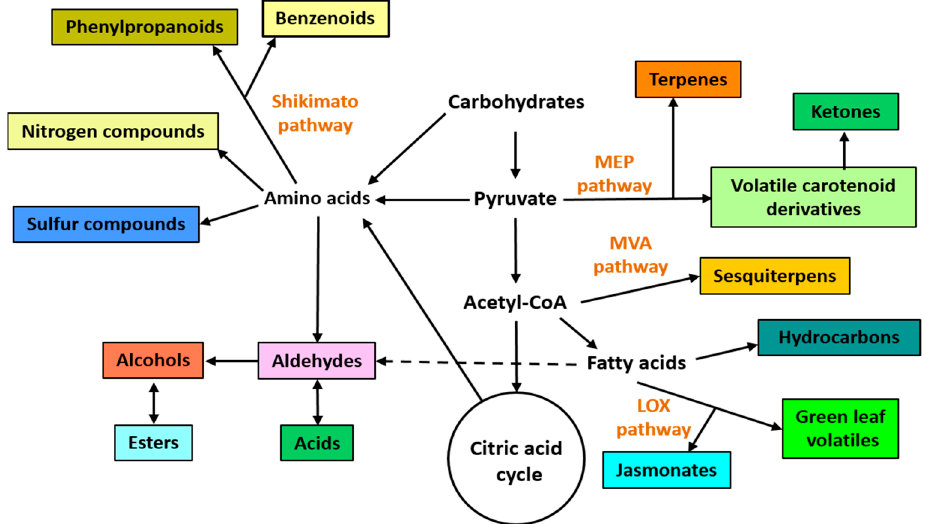
Figure 2. Overview of main biosynthetic pathways to produce plant and microbial volatile organic compounds. Different chemical classes of VOCs are depicted in colored rectangles. The four principal biosynthetic pathways are: the shikimate, the methylerythritol phosphate (MEP), the mevalonic acid (MVA), and the lipoxygenase (LOX) pathways.